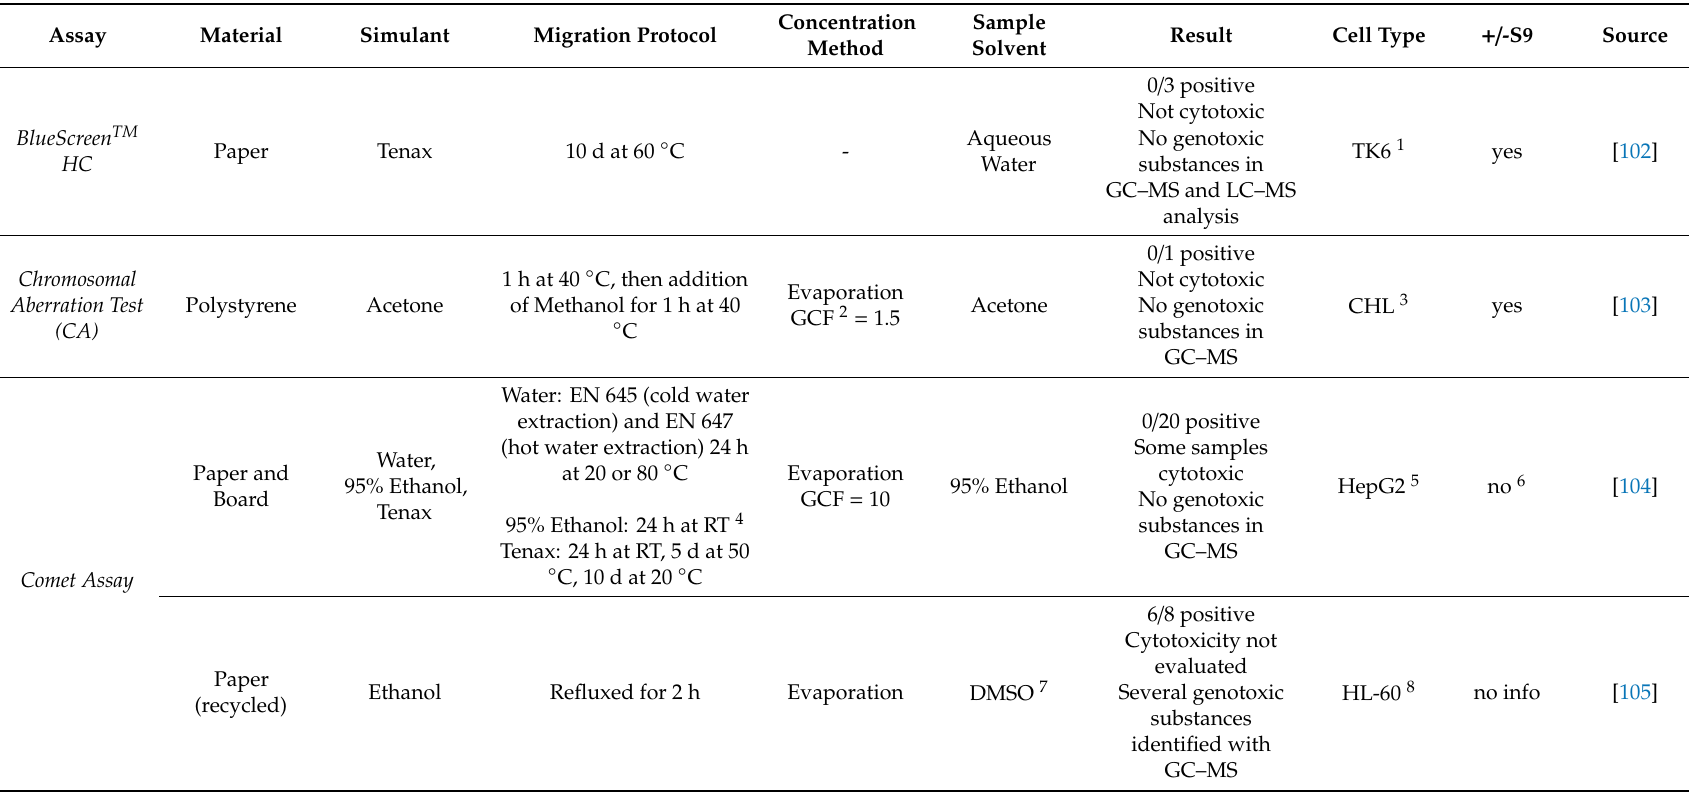
Table 4. Overview of the studies conducted on the genotoxicity of food contact materials (FCM) with common mammalian in vitro assays. The studies are arranged according to the conducted